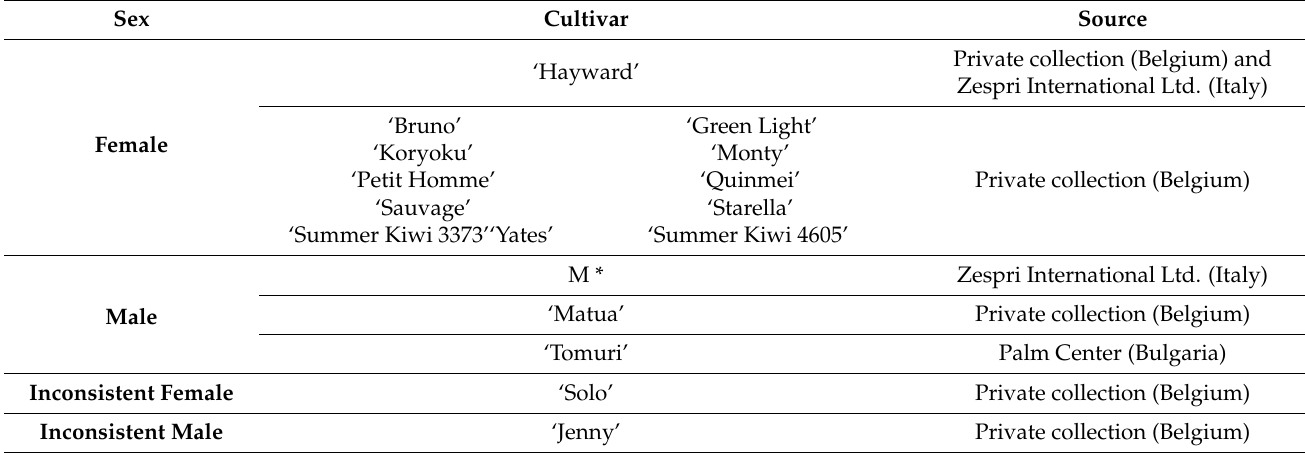
Table 2. Cultivars of Actinidia chinensis var. deliciosa used in sex-linked molecular markers